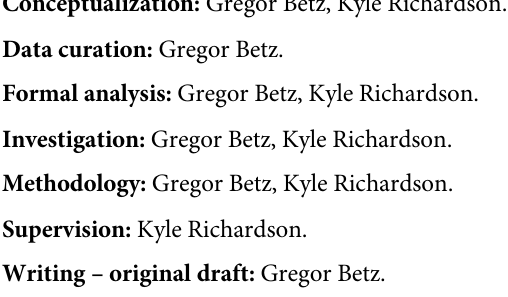
S11 Fig. Comparison of Popper metrics before and after evidence introduction. Compari- son of Popper Metrics before and after evidence introduction for different evidence introduc- tion regimes. Left column: inferentially closed pre-training corpora (reach= 1 ); right column: inferentially incomplete pre-training corpora (reach = 50). S12 Fig. Comparison of Consistency metrics before and after evidence introduction. Com- parison of Consistency Metrics before and after evidence introduction for different evidence introduction regimes. Left column: inferentially closed pre-training corpora (reach= 1 ); right column: inferentially incomplete pre-training corpora (reach = 50). S13 Fig. Comparison of joint entropy and evidence belief before and after evidence intro- duction. Comparison of joint entropy and evidence belief before and after evidence introduc- tion for different evidence introduction regimes. Left column: inferentially closed pre-training corpora (reach= 1 ); right column: inferentially incomplete pre-training corpora (reach = 50). (PDF) S1 Table. Statistical comparison of metrics pre and post evidence introduction. Statistical comparison of metrics pre (steps 0–299) and post (steps 300–600) evidence introduction for evidence integration regime “prompt”: standard deviation of metric pre evidence introduction (STD PRE); difference in means post vs pre (DELTA MEAN); p-value of t-test for indepen- dence of pre and post metric samples (p); mean difference relative to standard deviation (DELTA/STD); boolean variable indicating statistically significant (p < 0.05) deterioration of metric